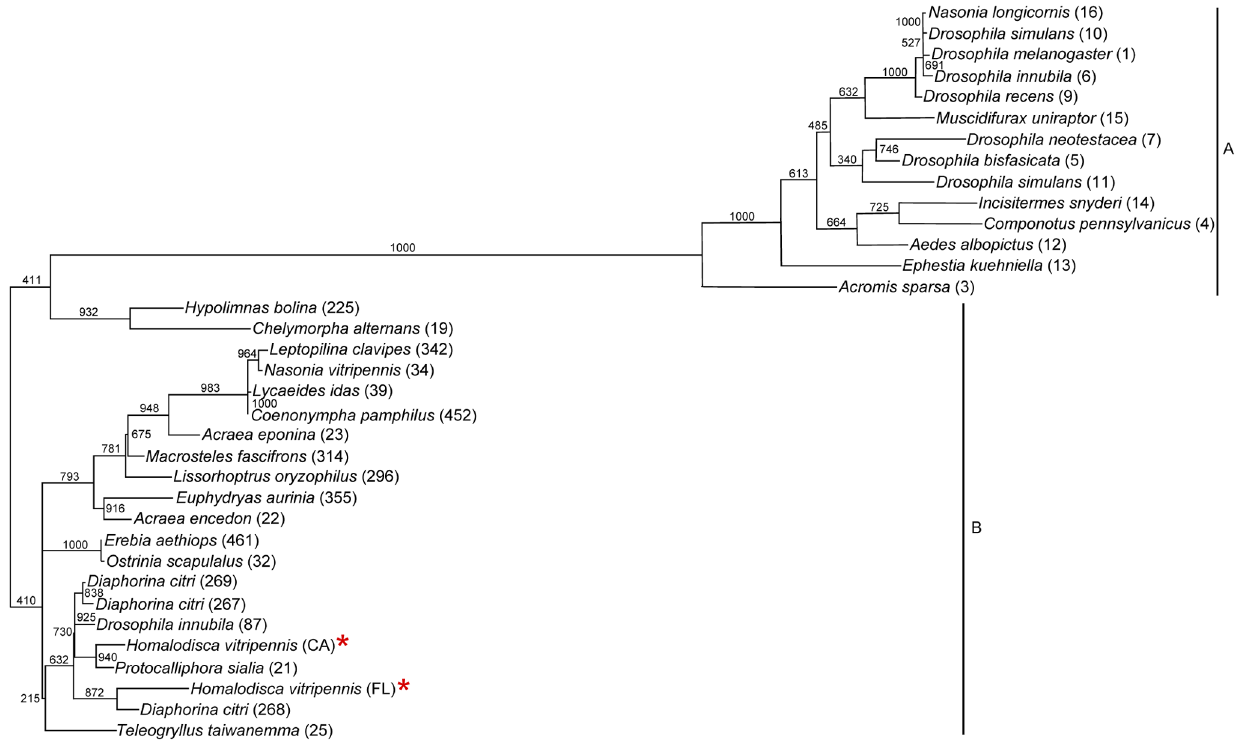
Figure 3. Phylogeny of Wolbachia MLST genes from various insects. A maximum likelihood tree (1000 bootstrap replicates) is based on multiple alignments of concatenated DNA sequences encoding the coxA , fbpB , ftsZ , gatB , hcpA , and wsp genes. Bootstrap values are shown for all nodes; red asterisks indicate sequences from this study. Sequence types from pubmlst.org/wolbachia are given in parentheses. Lines to the right indicate Wolbachia supergroups A and B.